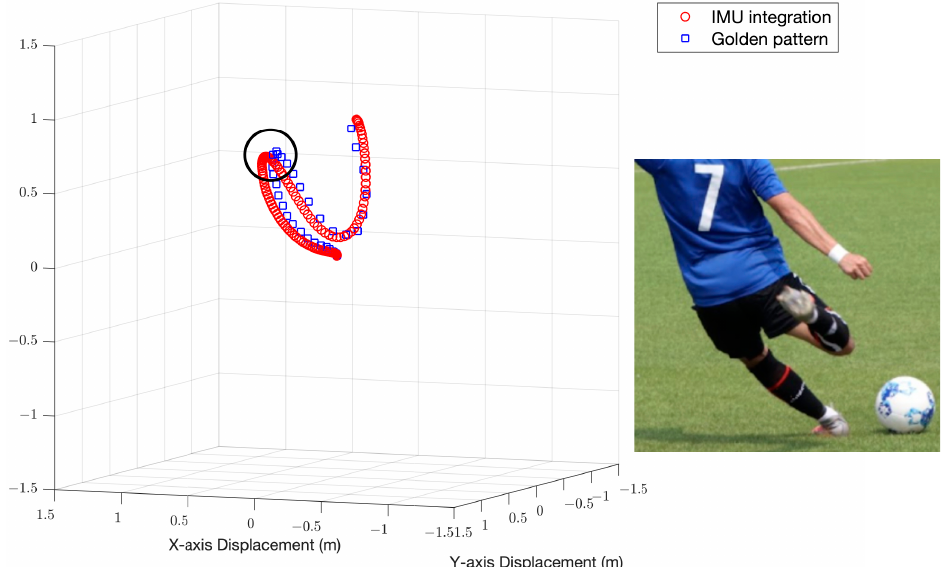
Figure 5. Three-dimensional trajectory diagram with backswing height illustrated. An error of 2.8% is achieved for an average backswing height of 0.756 m. The image on the right shows the highest point during the backswing.